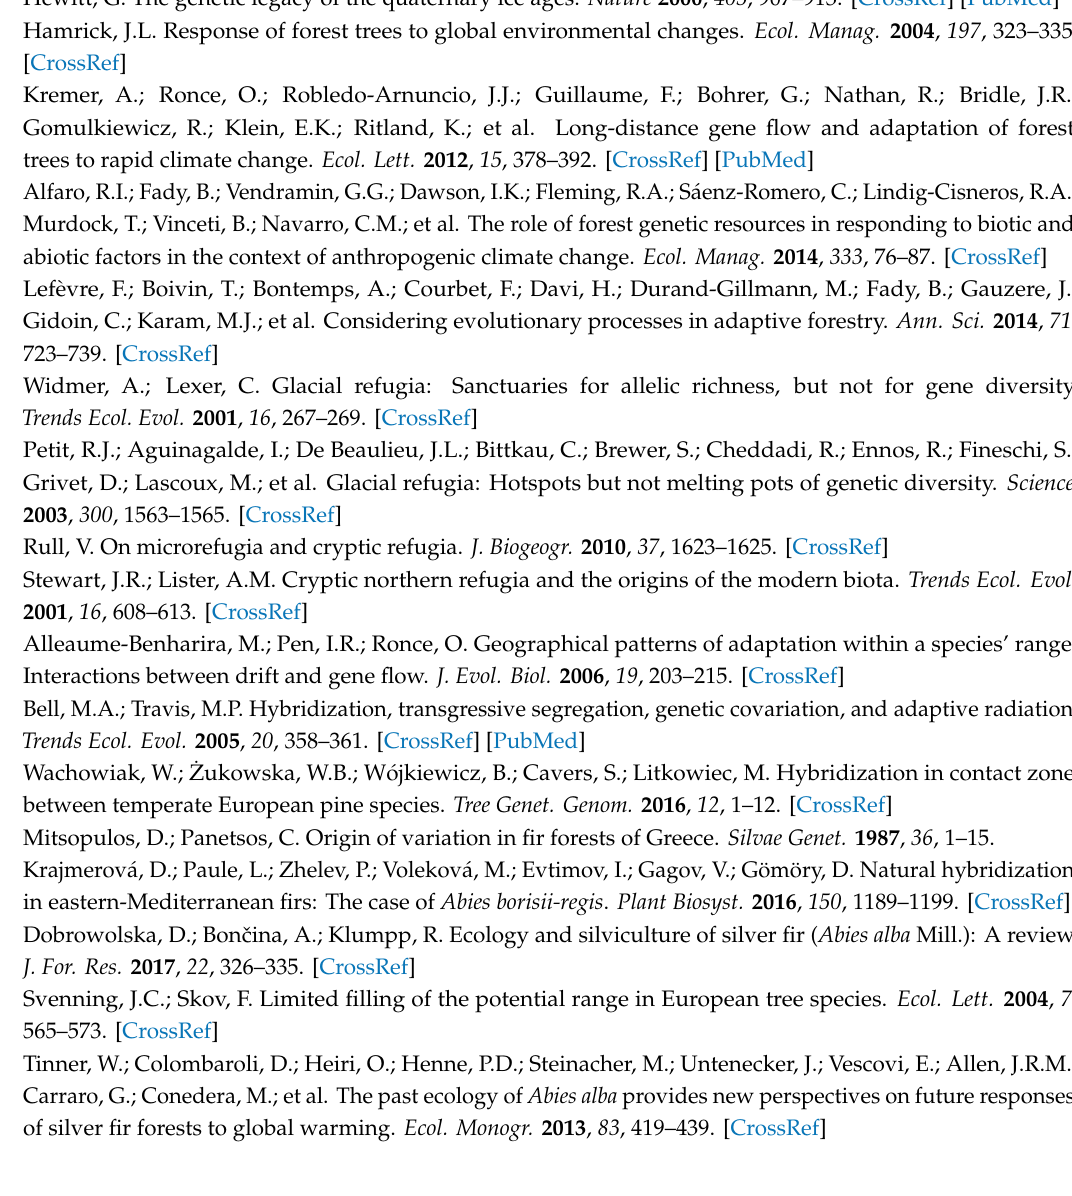
western (W) maternal lineages, Table S3: Characteristics of the five SSR loci for the eastern (E) and western (W) maternal lineages, Figure S1: Relationships between the survival rate of the tested provenances after 15 years and the geographic distance between their origin sites and the meeting zone of the refugial lineages. The test sites are ordered concordant with their geographic location from east to west, Figure S2: Relationships between the mean heights reached at age of 15 years by the tested provenances and the geographic distance between their origin sites and the meeting zone of the refugial lineages. The test sites are ordered concordant with their geographic location from east to